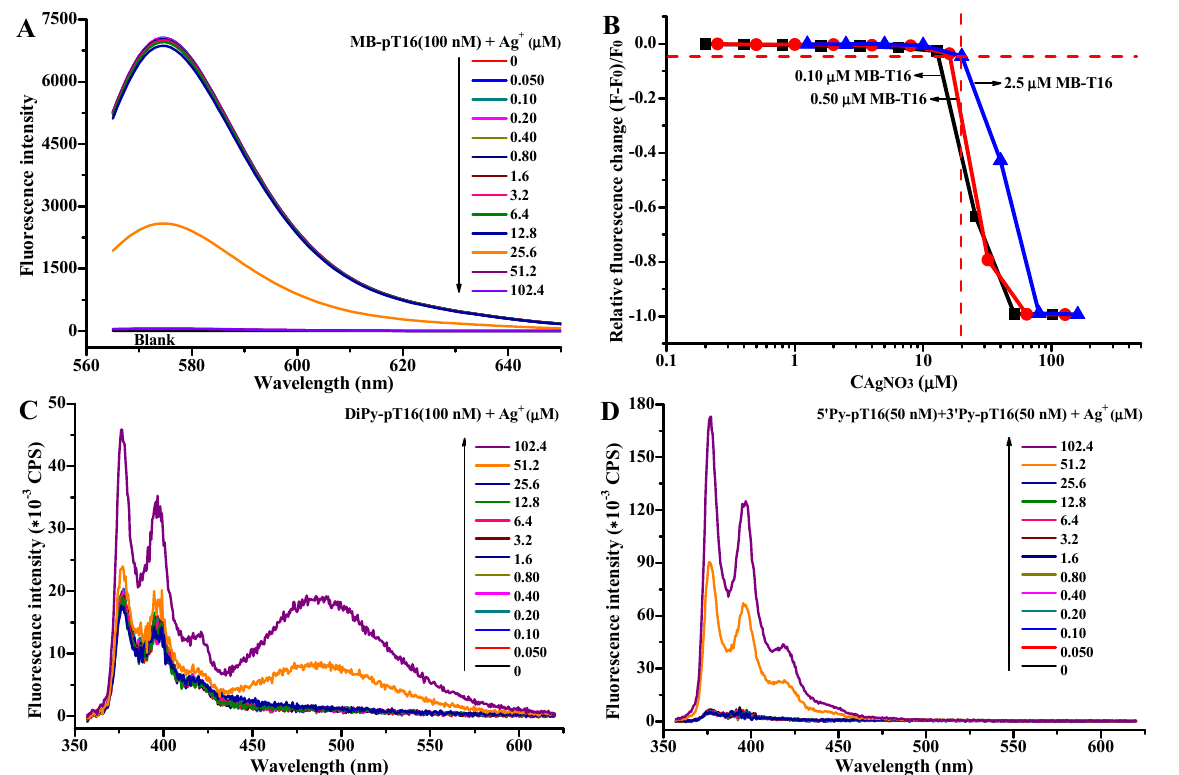
Figure 4. Fluorescence emission spectra of 100 nM MB-pT16 ( A ), 100 nM DiPy-pT16 ( C ), and the 50 nM equimolar mixture of 5 (cid:48) Py-pT16 with 3 (cid:48) Py-pT16 ( D ) in the absence and presence of 0.050, 0.10, 0.20, 0.40, 0.80, 1.6, 3.2, 6.4, 12.8, 25.6, 51.2, and 102.4 µ M AgNO 3 . ( B ) Plots of the relative fluorescence change in TMR at 578 nm against the concentration of AgNO 3 for 100 nM (black square), 500 nm (red circle), 2500 nM (blue uptriangle) MB-pT16. The reaction conditions are the same as those for Figure 1. The excitation wavelengths for TMR and pyrene were set at 557 and 347 nm, respectively. The excitation and emission slit bandwidths were both set at 5 nm. F 0 and F were the fluorescence intensities of MB-pT16 at 578 nm in the absence and presence of AgNO 3 , respectively. It is known that pyrene is a spatially sensitive fluorescent dye, which can form excimer (excited-state dimer) upon close encounters and emits fluorescence at longer wavelengths than monomer [55]. This characteristic of the distance-dependent excimer formation of pyrene has been exploited for the DNA single nucleotide polymorphisms detection, DNA-binding targets sensing and DNA structure analysis [56–58]. To further confirm the cooperative formation of intramolecular T-Ag + -T in polyT oligonucleotide, we designed and synthesized another three pT16 oligonucleotide probes having pyrene moieties at their 5 (cid:48) - and/or 3 (cid:48) -ends (DiPy-pT16, 5 (cid:48) Py-pT16, and 3 (cid:48) Py-pT16; Table 1). The effects of AgNO 3 on the fluorescence of 100 nM DiPy-pT16 and the 50 nM equimolar mixture of 5 (cid:48) Py-pT16 and 3 (cid:48) Py-pT16 were investigated in the same manner as that for the above turn-off molecular beacon. As shown in Figure 4C,D, the monomer emission peaks (at 376 and 397 nm) are observed, which exhibit almost no change when the concentration of Ag + is lower than the threshold value (40 µ M) obtained by UV experiments. However, a new excimer peak appears at 485 nm for the DiPy-pT16 probe when the concentration of Ag + is higher than 40 µ M in solution, accompanying a slight increase in monomer fluorescence intensity. With regards to the equimolar mixture of 5 (cid:48) Py-pT16 and 3 (cid:48) Py-pT16, no excimer peak is observed, even though the monomer fluorescence intensities increase sharply in the presence of 51.2 and 102.4 µ M AgNO 3 . The results for this distance-dependent light- switching probe further confirm that Ag + ions are cooperatively incorporated into pT16 via an intramolecular interaction